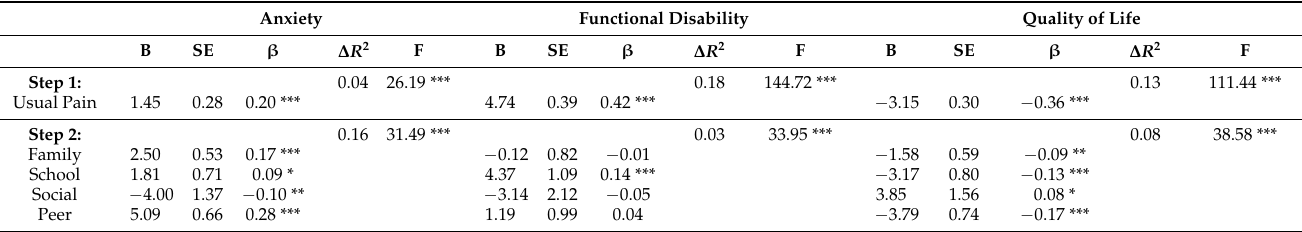
Table 1. Prediction of pain-related outcomes with stressor